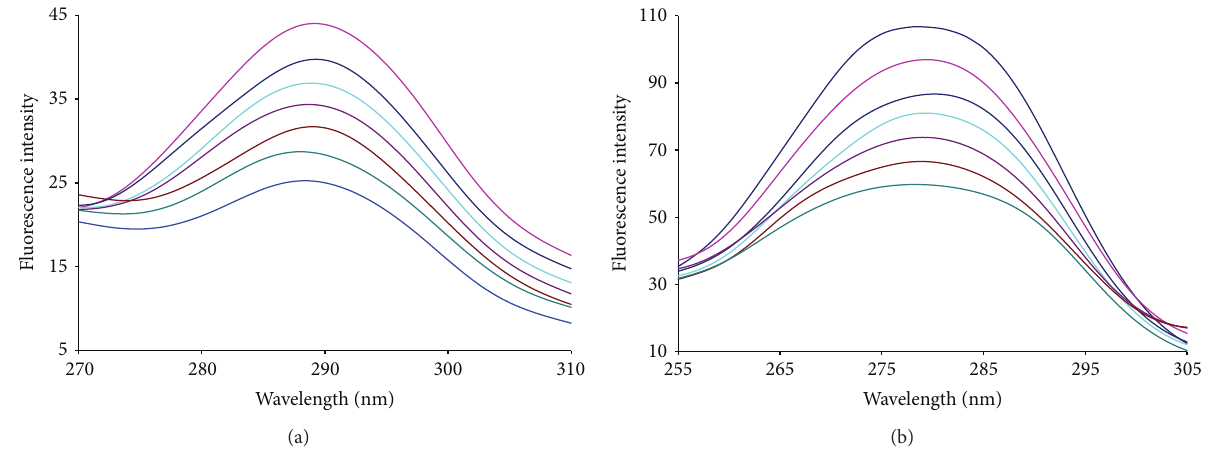
Figure 6: Synchronous fluorescence spectra of interaction between HAase and liquiritigenin at (a) Δ𝜆 = 15 nm and (b) Δ𝜆 = 60 nm at room = (0,4.0, 8.0, 12.0, 16.0, 20.0, 24.0, 30.0) × 10 −6 molL −1 , 𝐶 temperature. Peak from up to down 𝐶 liquiritigenin